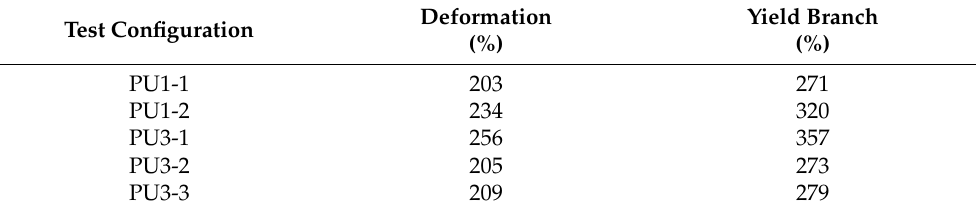
Table 5. Deformation and yielding regime extension compared to PCF configuration.